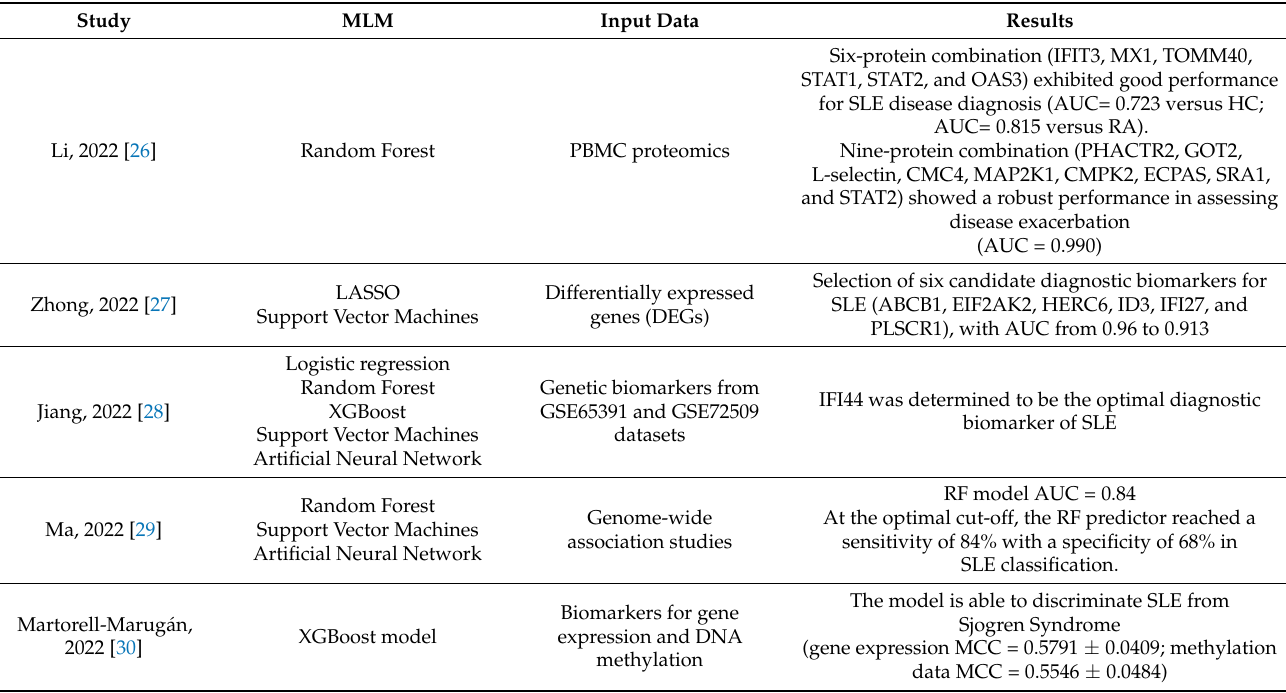
Table 1. Main data about the studies applying Machine Learning Models for diagnostic